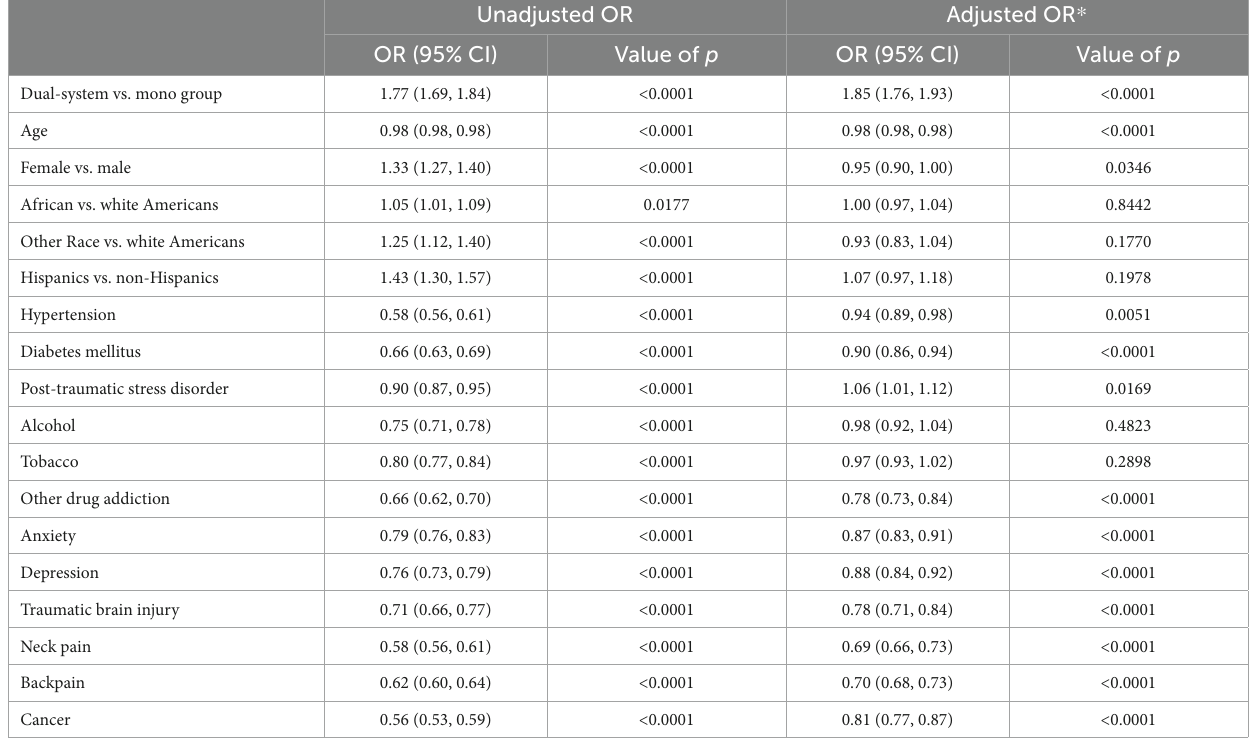
TABLE 4 New opioid prescription in mono vs. dual-system users in DC and Baltimore VA from 2015 to